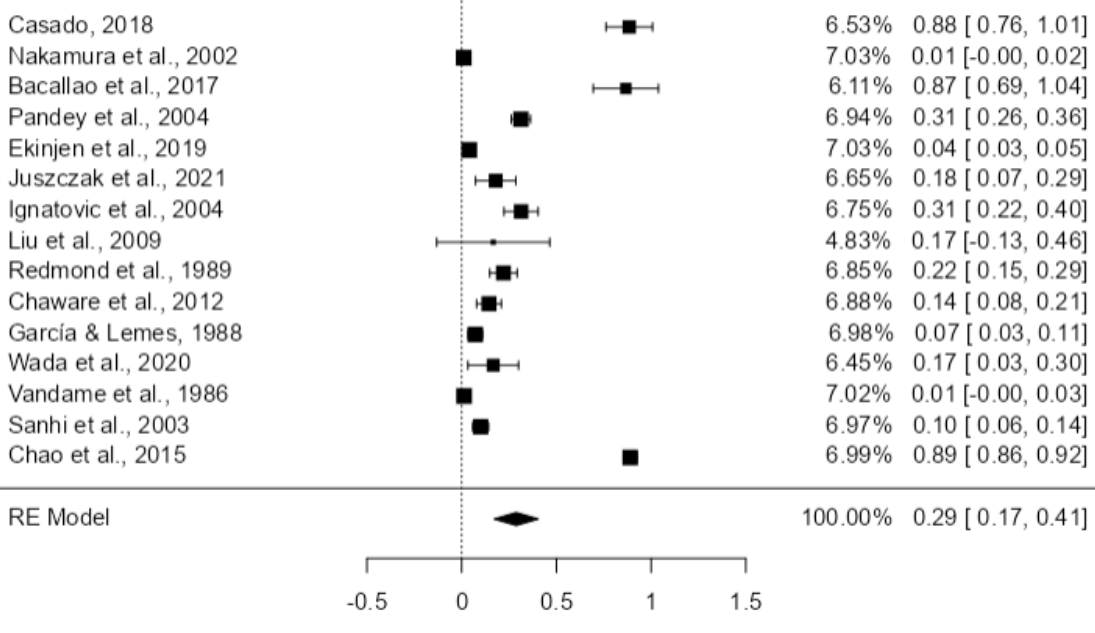
Figure 7. Forest plot of prevalence of the variations of the SA of the included studies [3,6,10,14,16,34,36 – 44].